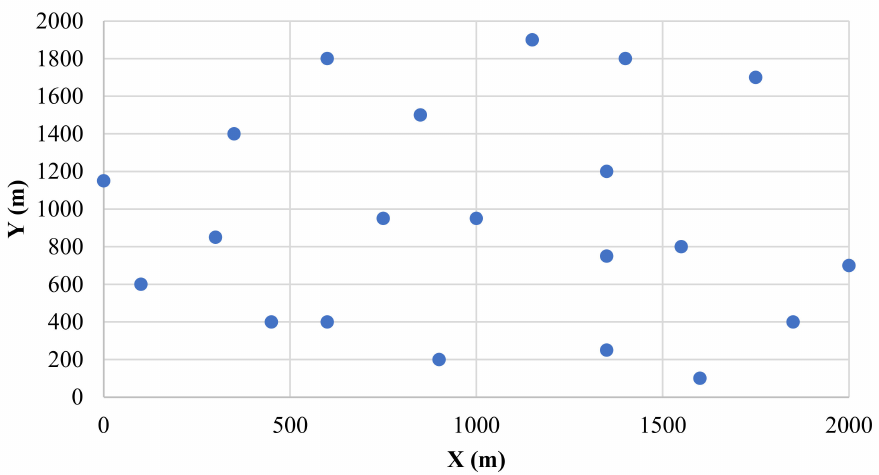
Figure 15. Layout of the 2-D